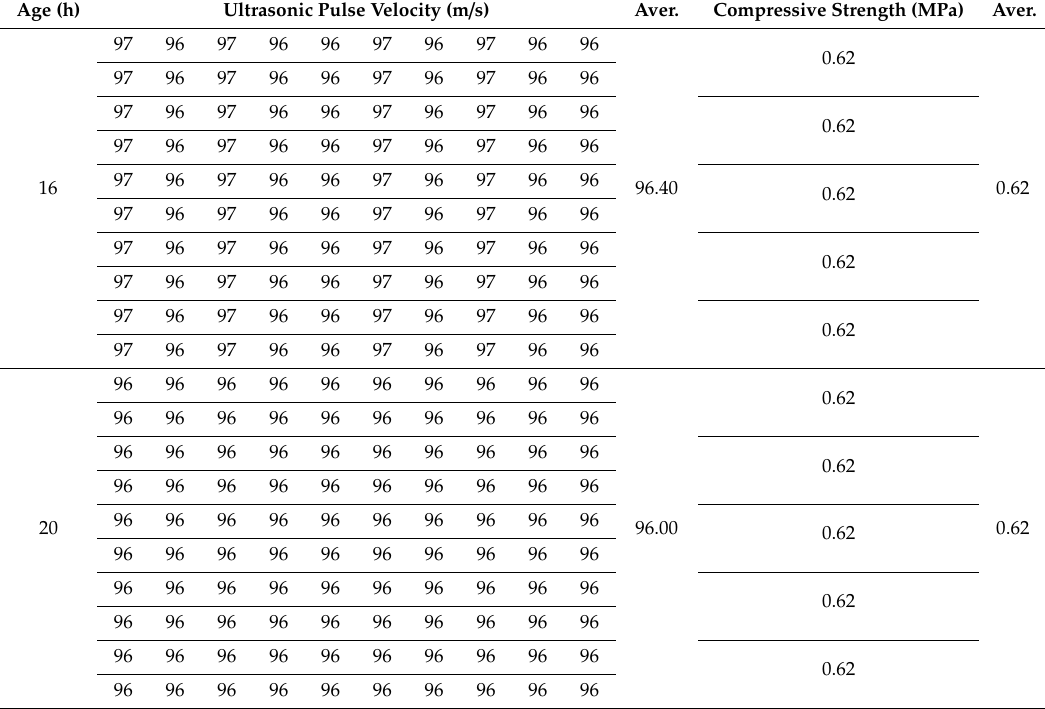
Table 4. Experiment results (40